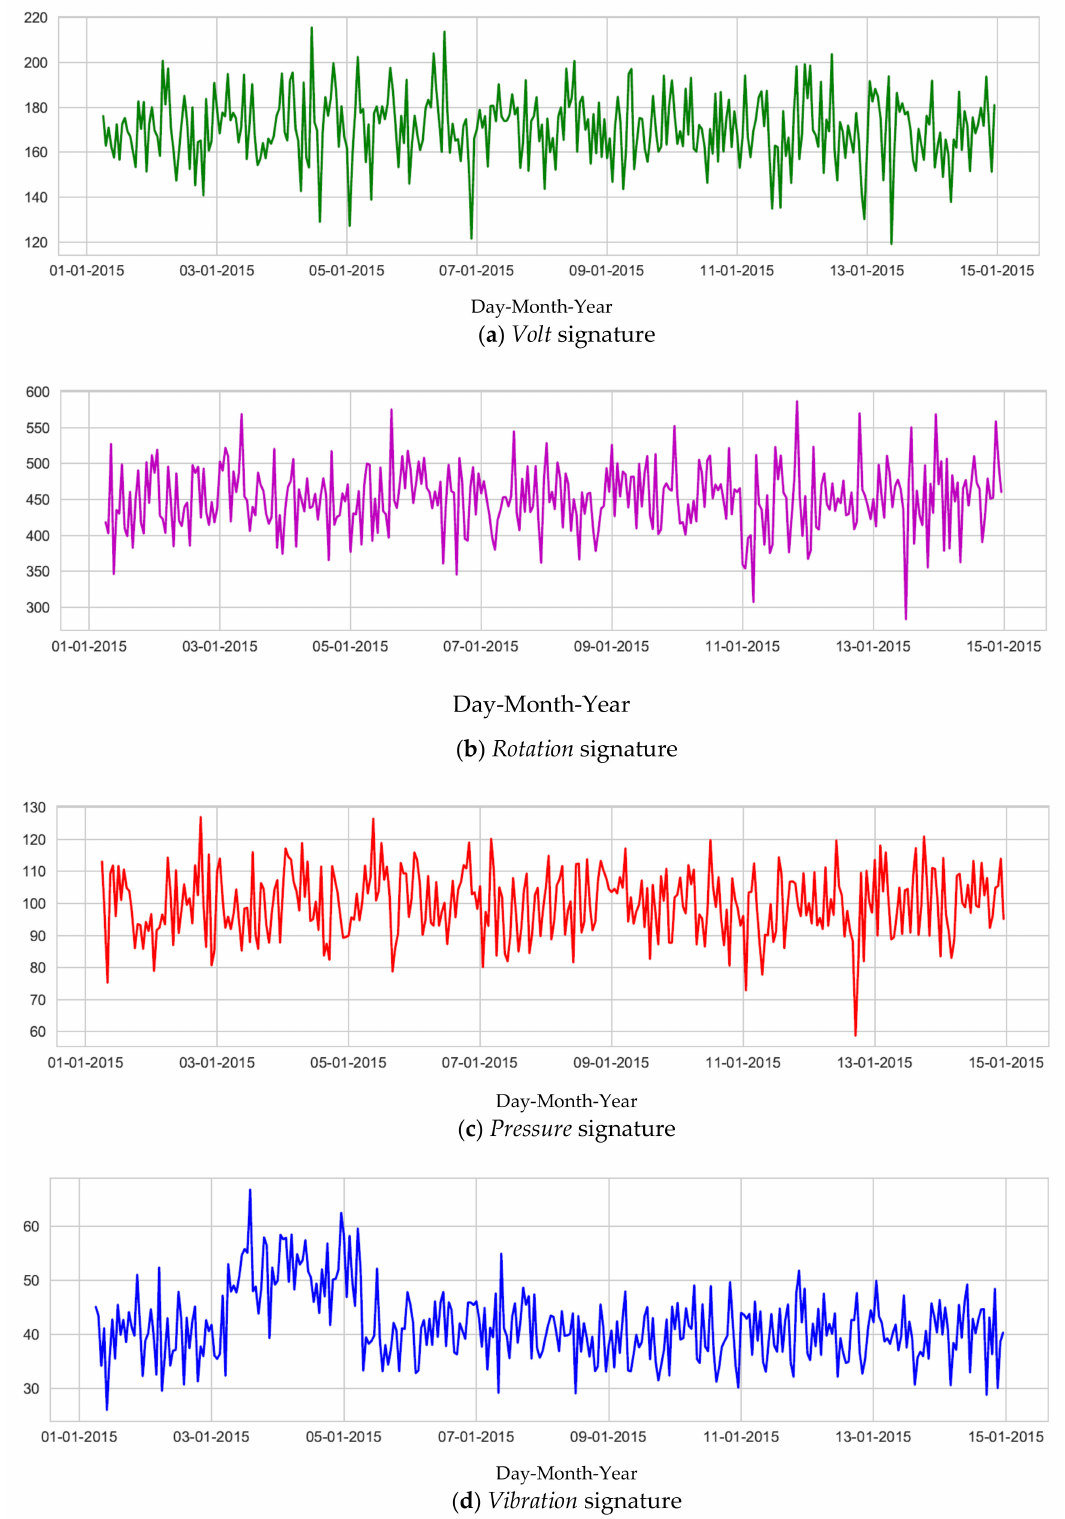
Figure 2. Evolution of Telemetry data over the first fifteen days of January 2015, for the machine